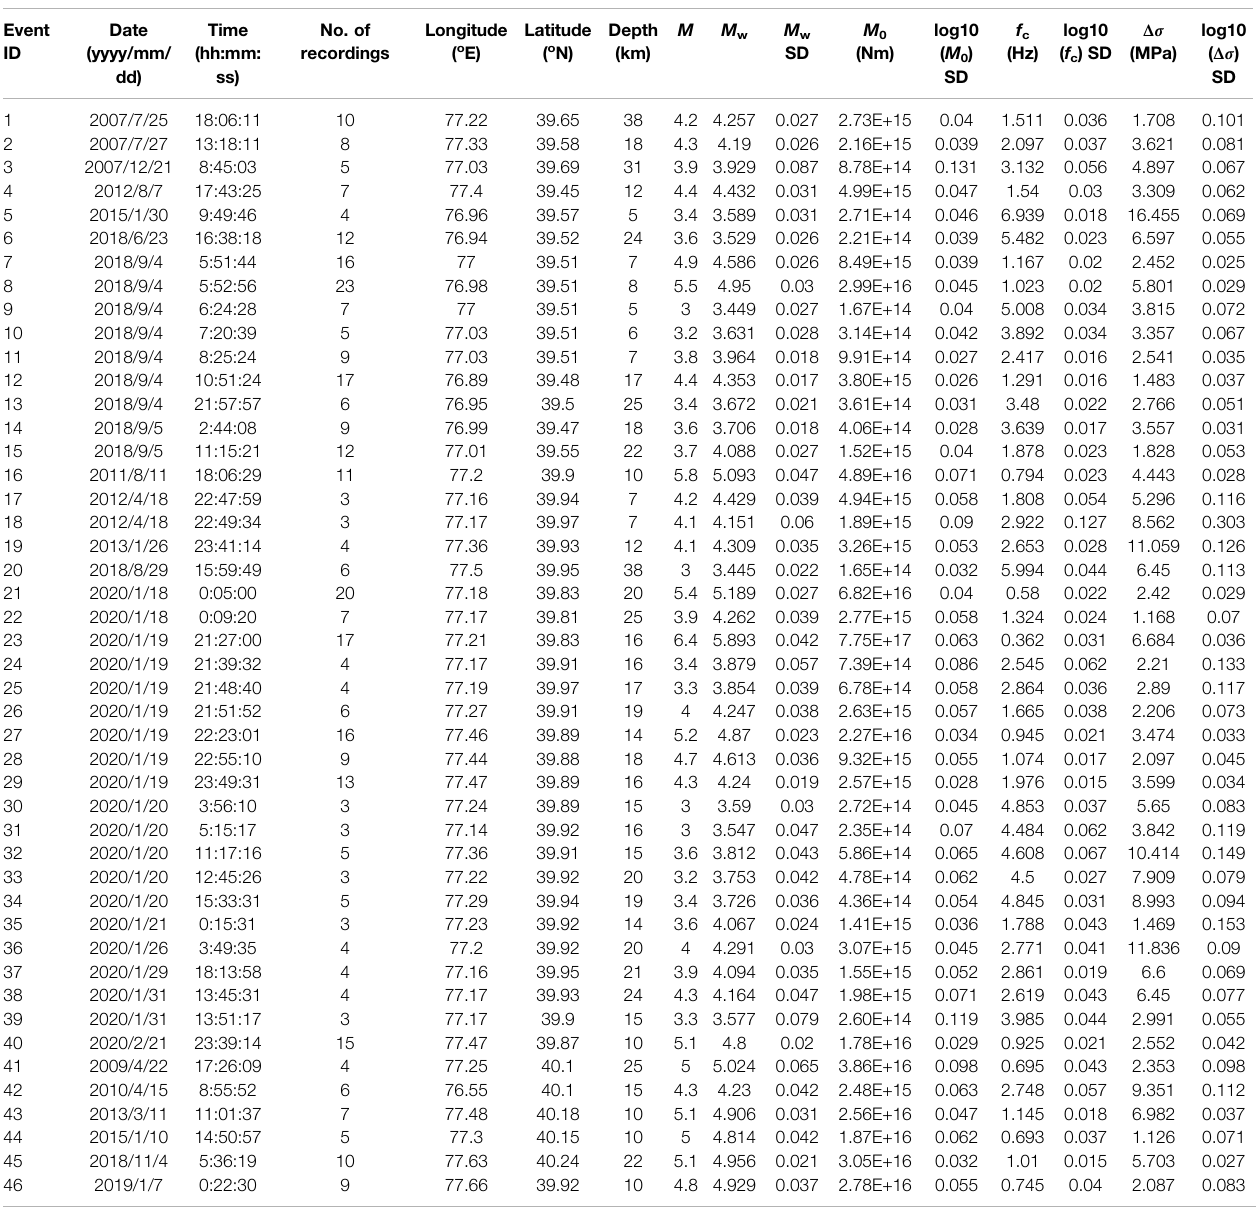
TABLE 1 | Basic information for earthquakes under investigation and source parameter